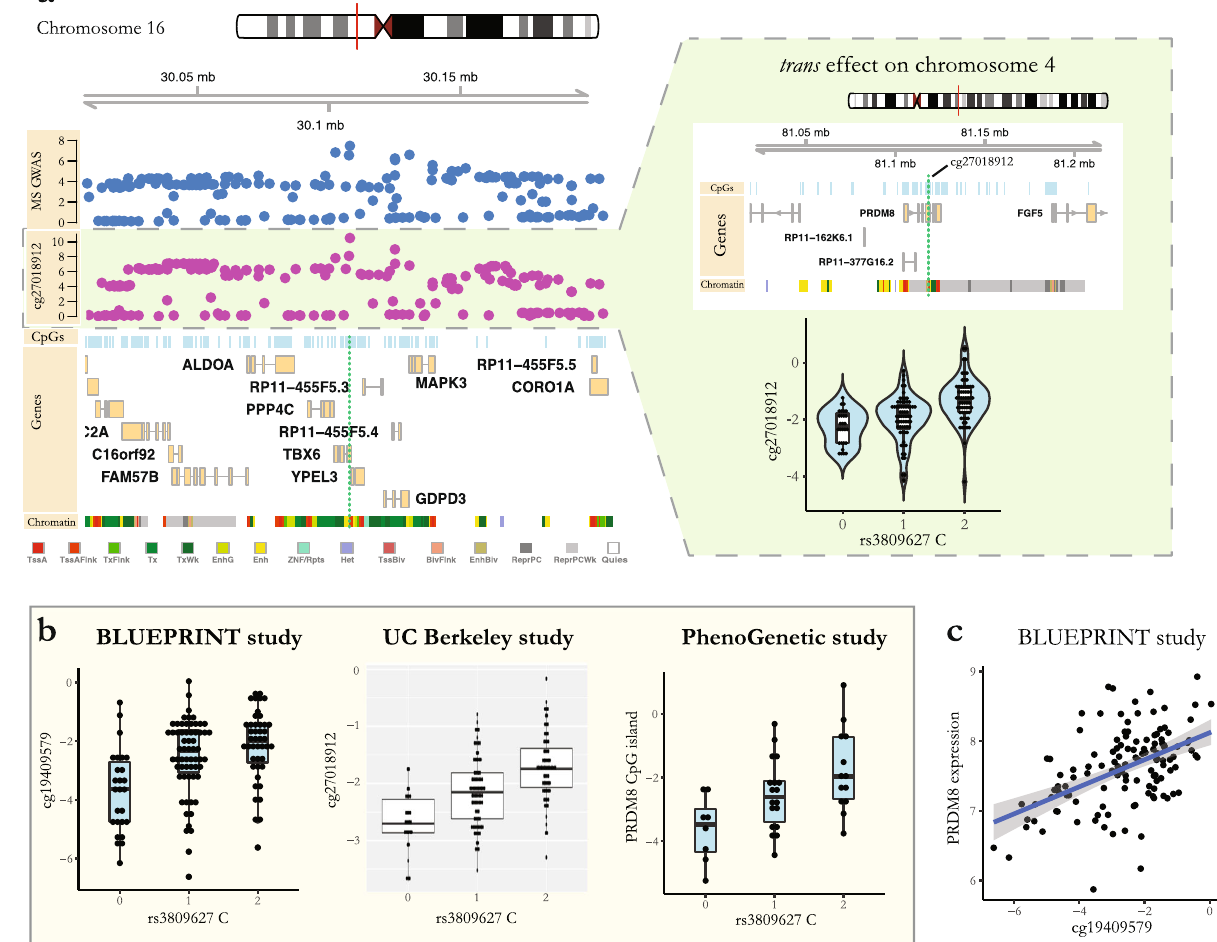
Fig. 3 Colocalized trans -mQTL effect of MS susceptibility locus centered on rs3809627. a The top colocalized MS- trans -mQTL effect observed between MS susceptibility locus centered on rs3809627 in chromosome 16 and cg27018912 located in a CpG island in chromosome 4. Left: Association (-log( p - value)) between SNPs located in the chromosome 16 locus and MS susceptibility (blue dots) and the trans -mCpG cg27018912 methylation levels (plum dots), accompanied by visualization of the CpGs, genes and modeled chromatin states in the chromosome 16 locus. Green vertical lines represent additional colocalized cis -mCpGs (posterior probability >0.8). Right: Genomic position of the trans -mCpGs (cg27018912, cg19409579 and cg04235768) on chromosome 4 (vertical green lines) in relation to nearby CpGs, genes, and modeled chromatin states. The top colocalized trans -mQTL effect is shown in the bottom using methylation M-values ( n = 156). b Replication of the identi fi ed trans -mQTL effect between rs3809627 MS susceptibility variant (chromosome 16) and CpGs in the CpG island located on chromosome 4 in three independent studies. Methylation levels are shown in M-values. Data is shown for cg19409579 in the BLUEPRINT study as the top available trans -mCpG measured with the In fi nium HumanMethylation450 array. Methylation data shown for the PhenoGenetic study are the average methylation levels of all the measured CpGs in the identi fi ed CpG island. Boxplot center lines represent median; box limits represent upper and lower quartiles. c Signi fi cant CpG-mRNA association was observed between cg19409579 trans -mCpG and PRDM8 gene expression in the BLUEPRINT study. Methylation levels are in M-values. Gene expression levels are ComBat normalized values available from the BLUEPRINT. Error band represents 95% con fi dence interval. Boxplots ( a , b ): center lines represent median; the lower and upper hinges correspond to the 25th and 75th percentiles; the lower/upper whisker extends from the hinge to the smallest/largest value no further than 1.5× inter- quartile We replicated our trans -mQTL fi nding - rs3809627 on chromosome 16 and the chromosome 4 CpG island — in three independent datasets (Fig. 3b). First, we found the same effect using the BLUEPRINT naïve CD4 + T cell DNA methylation data ( p = 4.8 × 10 − 6 ). Second, we replicated the trans -mQTL in a dataset of DNA methylation pro fi les from whole blood of 208 MS patients from UC Berkeley ( p = 5.4 × 10 − 13 ). Third, we analyzed targeted methylation data from CD4 + T cells puri fi ed from 48 healthy participants in the PhenoGenetic study 13 ( p = 7.1 × 10 − 4 ) (see “ Methods ” for more details). These results generate high con fi dence in the trans -mQTL effect of rs3809627 and establish it